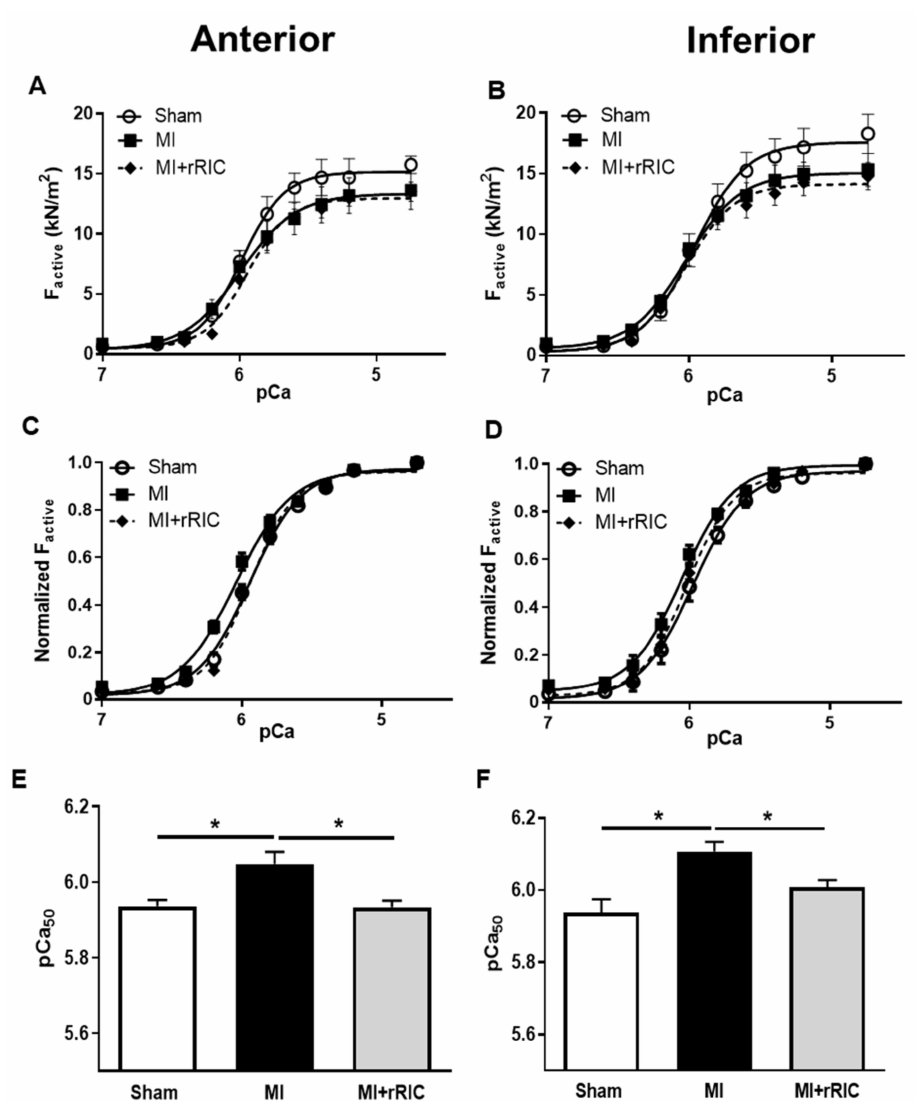
Figure 5. Ca 2+ -sensitivity of force production (pCa 50 ) in isolated, permeabilized cardiomyocytes of the anterior ( A , C , E ) and inferior LV areas ( B , D , F ). Absolute values of activate force (F active ) production in isolated myocyte-sized preparations at different Ca 2+ concentrations in the anterior ( A ) and inferior ( B ) areas from the Sham, MI, and MI + rRIC groups. Sarcomere length was adjusted to 2.3 µ m. F active values at submaximal Ca 2+ concentrations (pCa 5.4–7.0) were expressed relative to F max (pCa 4.75) to determine normalized pCa-force relationships ( C , D ). Bar graphs ( E , F ) highlight the midpoints of normalized pCa–force relationships. Data are expressed as mean ± SEM, * p < 0.05; n = 8 from at least four different